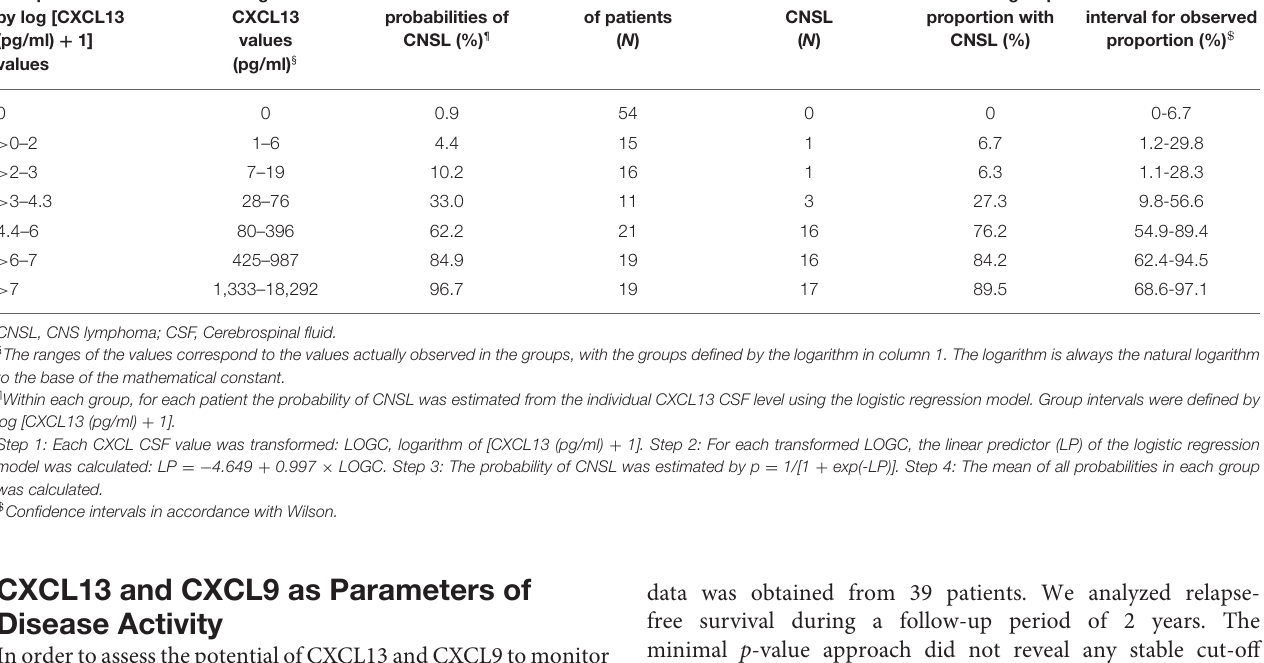
TABLE 3 | Probabilities for CNSL calculated from logistic regression in dependence on CXCL13 CSF levels. Groups defined by log